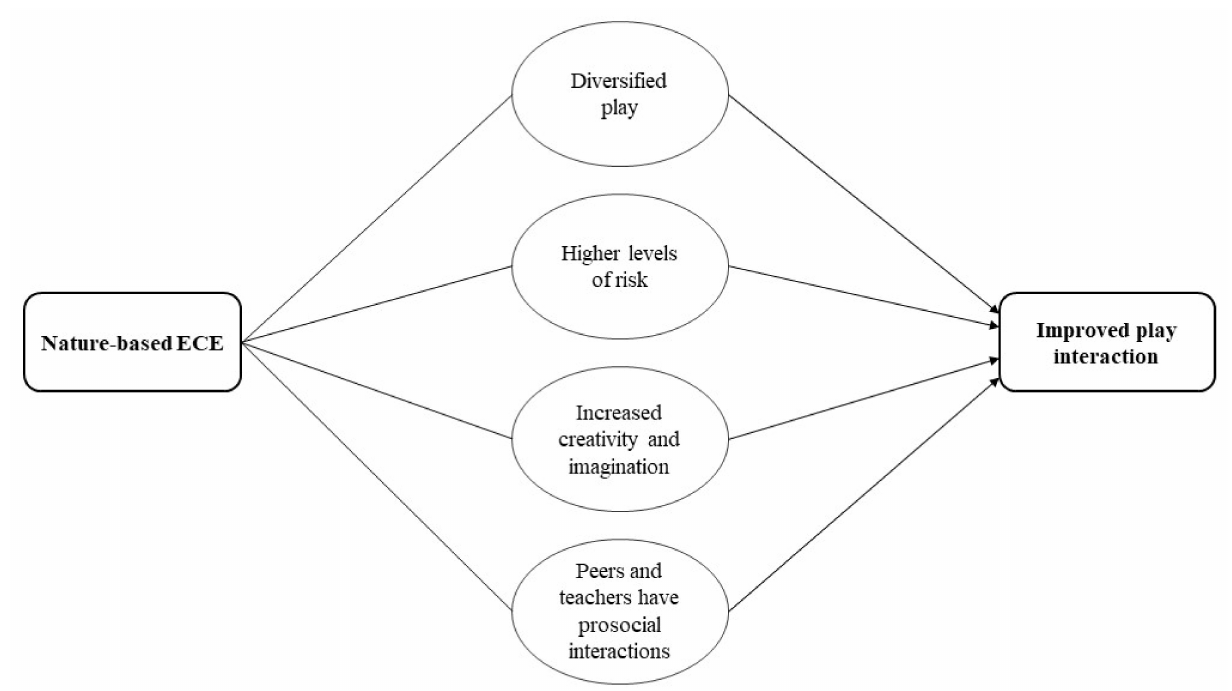
Figure 8. Convergent synthesis on how nature-based ECE could influence play interaction. An arrow denotes where factors lead to an influence on play